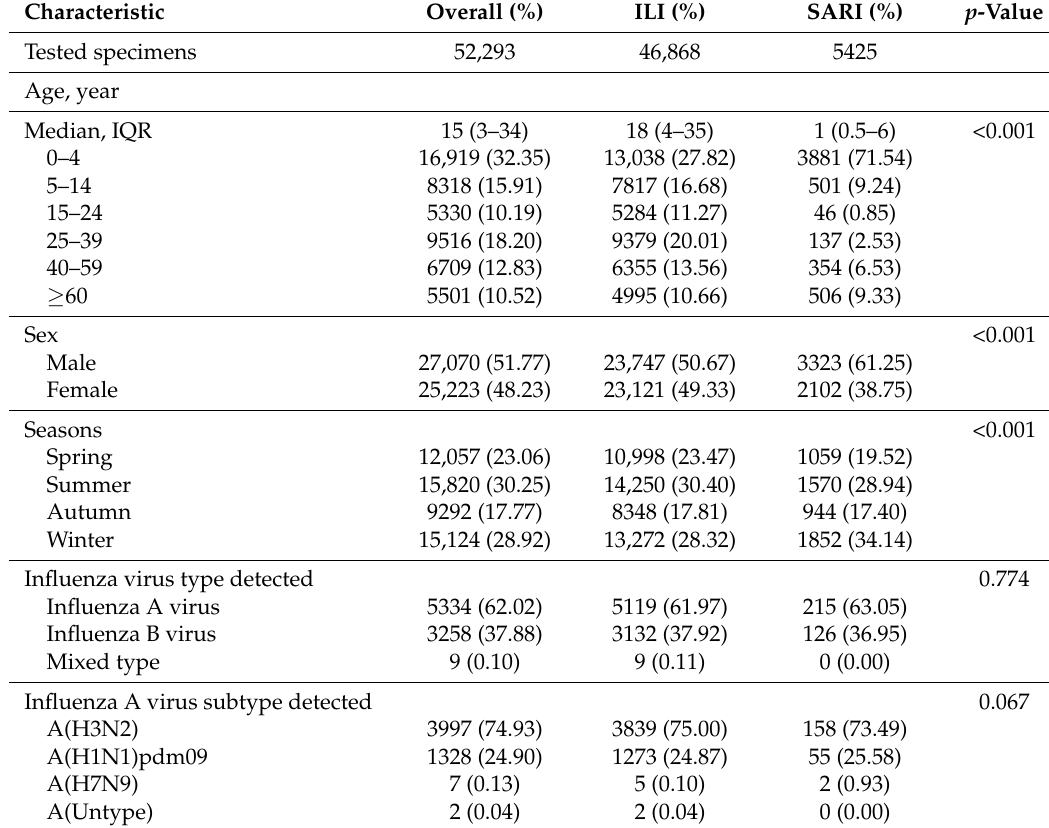
Table 1. Demographic and virologic characteristics of the sampled and tested patients by the